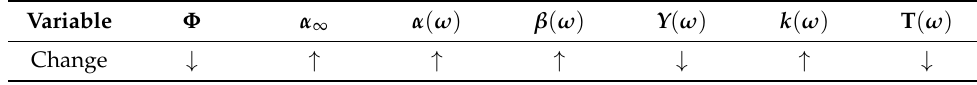
Table 3. Proportion of polyurethane foam reagents (note: ↑ —increase; ↓ —decrease).